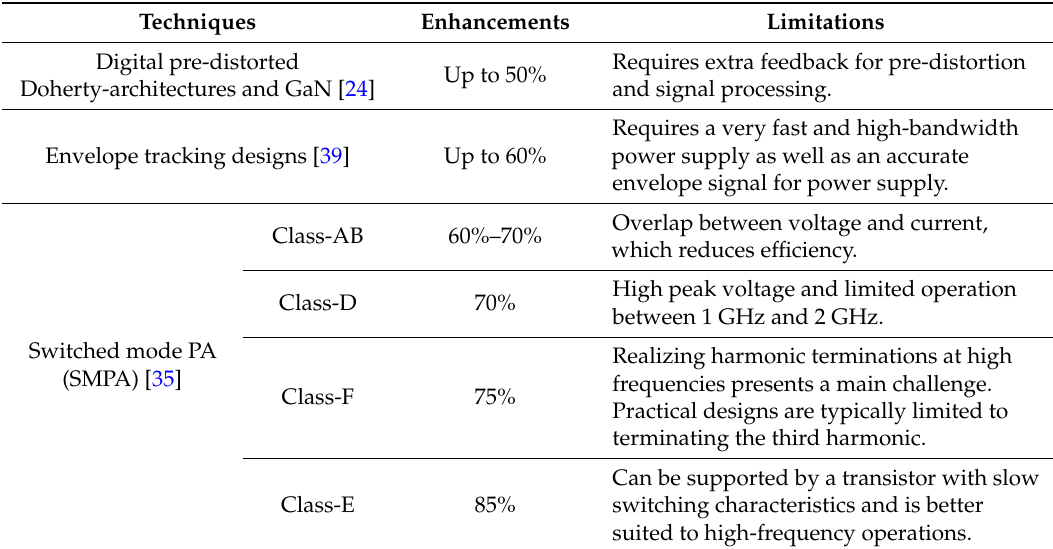
Table 2. Proposed techniques for improving PA